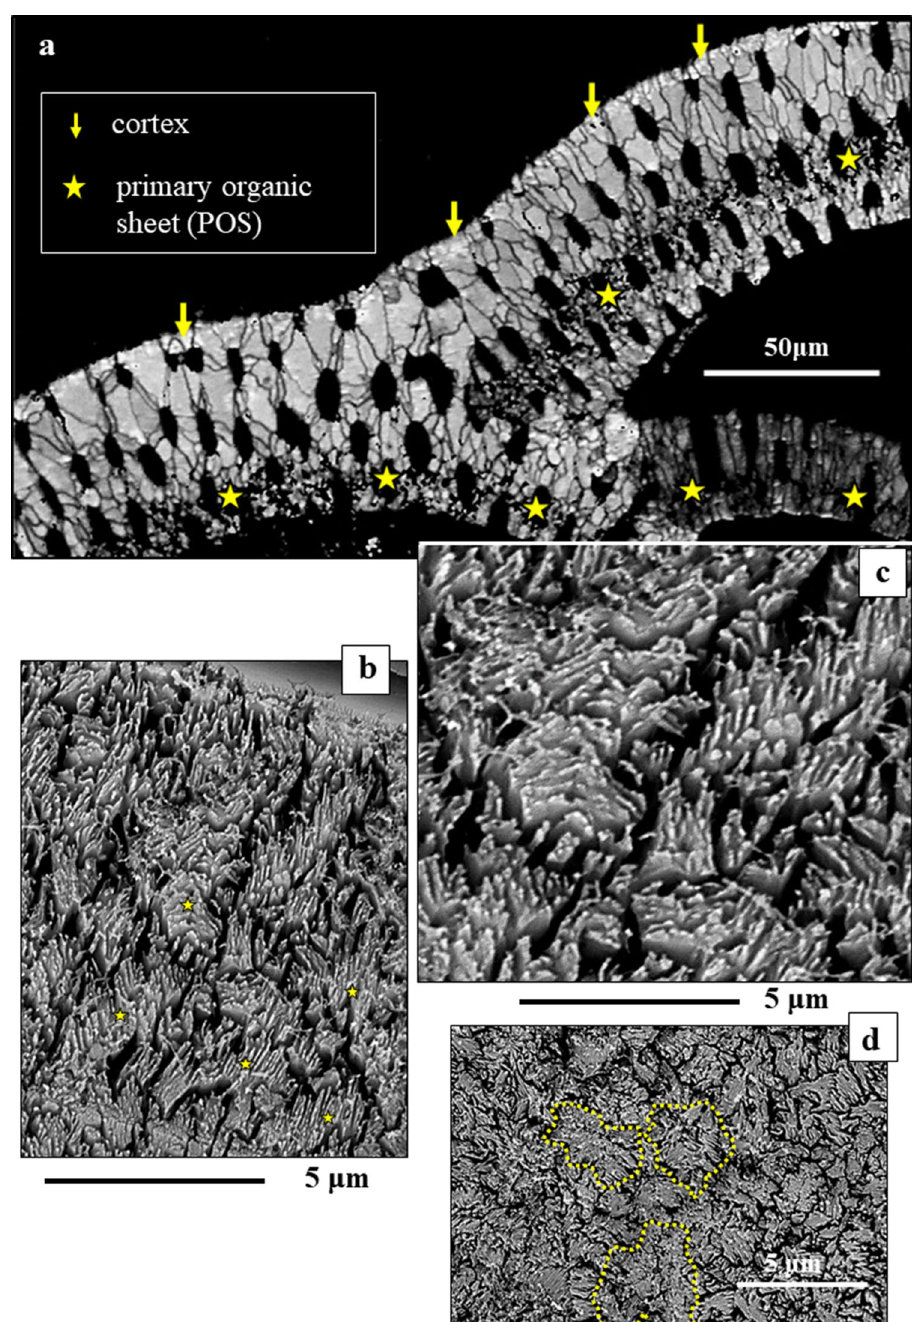
Figure 4. Tangentially oriented cut through the shell wall of Pulleniatina obliquiloculata ( a ) allowing view from above, onto the surface of the cone-shaped crystal units (( b )–( d )). The cone-shaped crystals are internally structured ( b , c ) and intertwine ( d ). ( a ) EBSD band contrast measurement in grey; ( b , c , d ) BSE images of etched surfaces. Yellow stars in ( a ) indicate the course of the POS, the latter is well-visible through the accumulation of small crystallites. Yellow arrows in ( a ) point to the cortex. Yellow dashed lines in ( d ) mark the outlines of the tangential surface of three cone-shaped